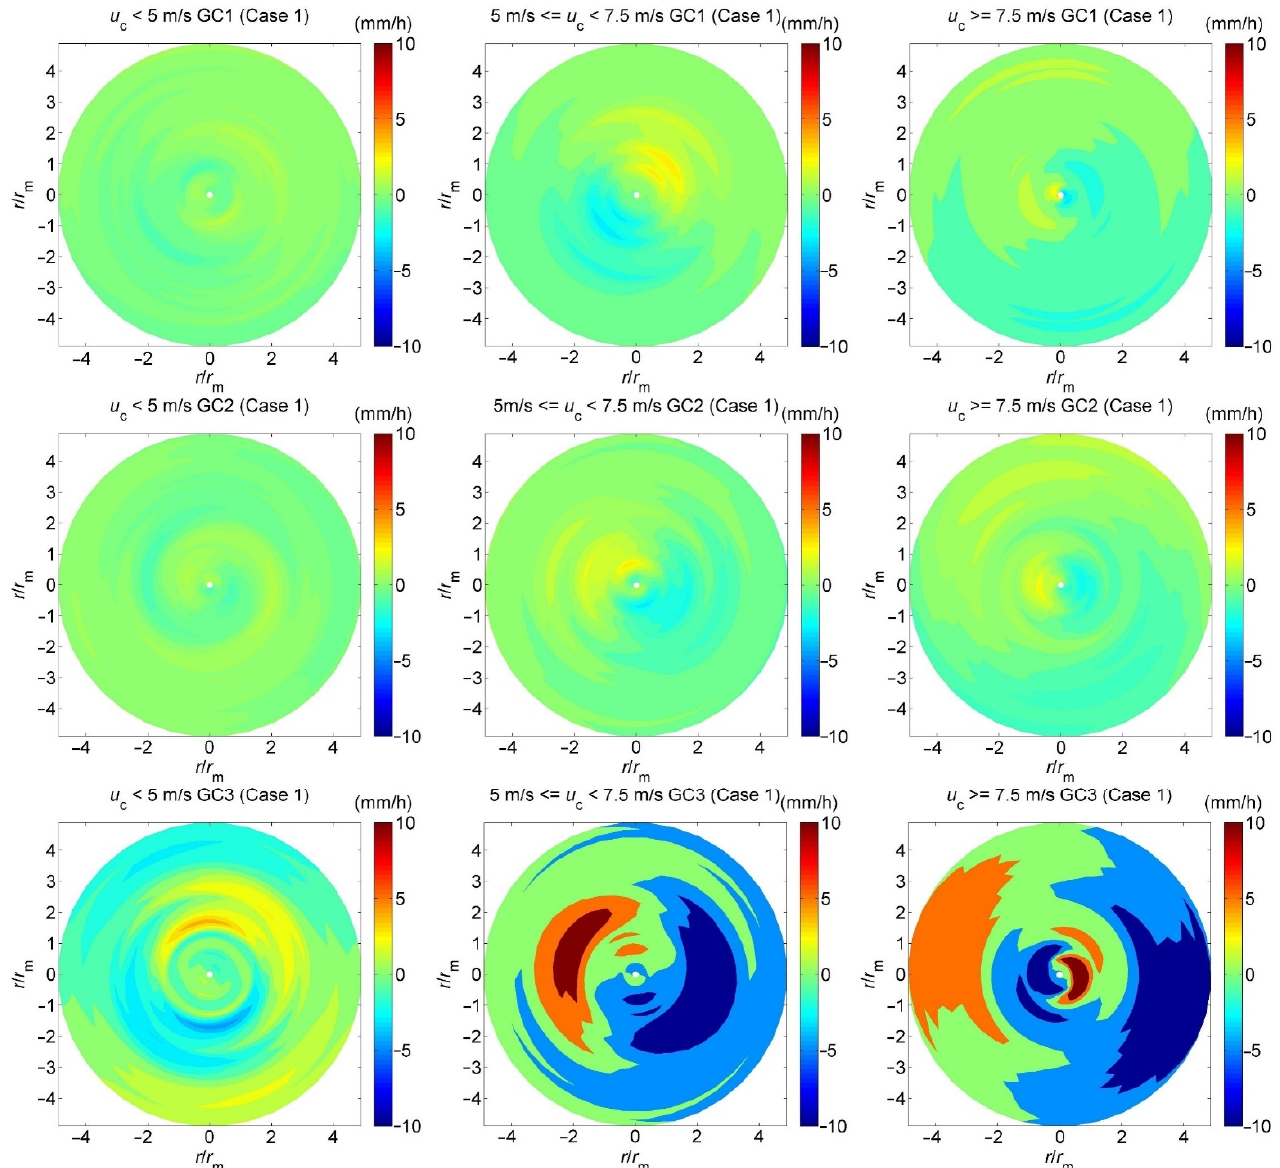
Figure 6. Asymmetric rainfall fields calculated based on the model coefficients shown in Figure 4 for Case 1.